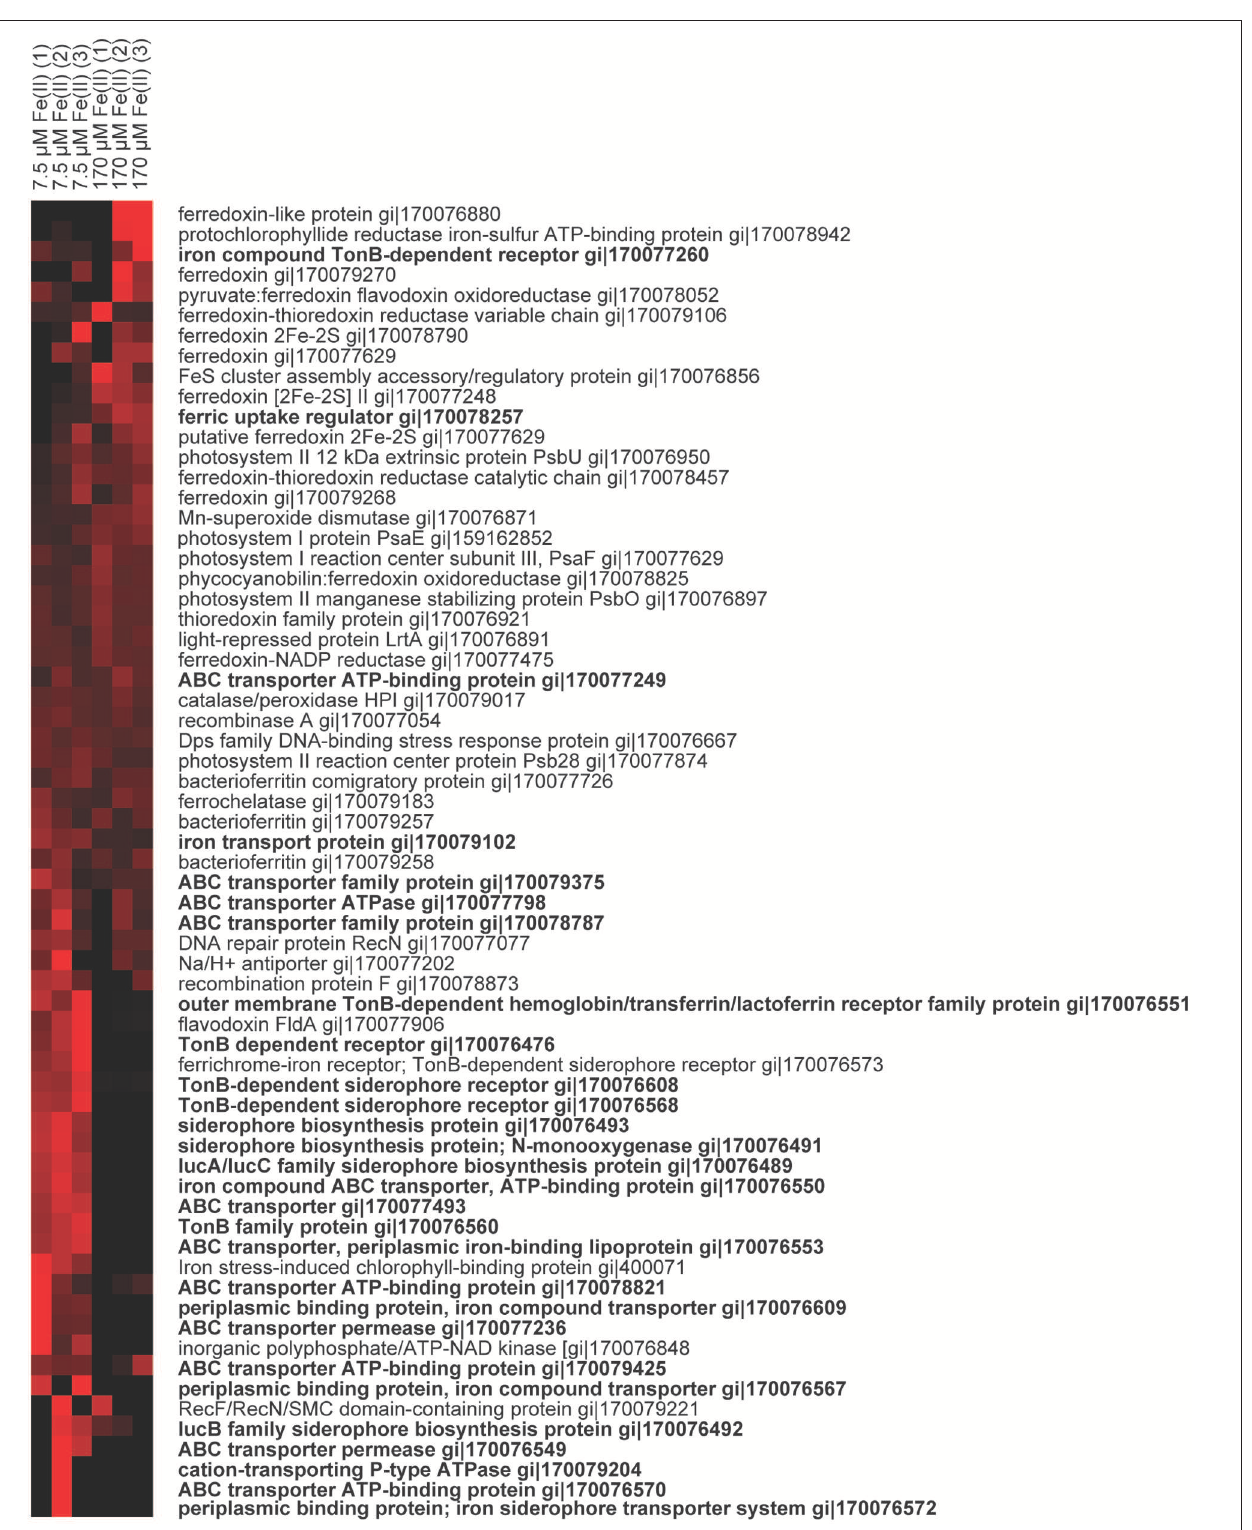
FIGURE 3 | Heatmaps of protein abundance from triplicated biological treatments with low Fe (left columns) vs. when high Fe (right columns) was supplied to Synechococcus PCC 7002 during growth. Each protein was normalized to the average spectral abundance of that protein across all experiments. Red indicates more abundant, black is lower abundance. Proteins in bold are involved in Fe uptake or siderophore biosynthesis and/or import/export. Accession numbers are given for each protein.